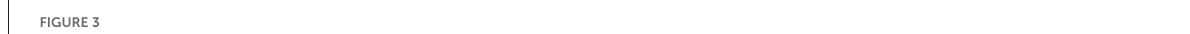
FIGURE3 as well as the disappeared signal in the posterior limb of the internal capsule. (B) T2WI sequence, brain swelling, the increased signal in white matter, the decreased signal in the thalamus and basal ganglia. (C) DWI, the extensive high signal in the frontal lobe, temporal lobe, occipital lobe, thalamus and corpus callosum on DWI (D) In ADC diagram, the whole brain area (CSF removal) was manually delineated as the regions of interest (ROIs) in each slice. (E) The histogram of ADC shows the positive skew distribution of asymmetric frequency distribution. The X -axis represents the ADC value, and the Y -axis denotes the pixel frequency corresponding to the ADC value. HIE, neonatal hypoxic-ischemic encephalopathy; CSF, cerebrospinal fluid; ROI, regions of interest.